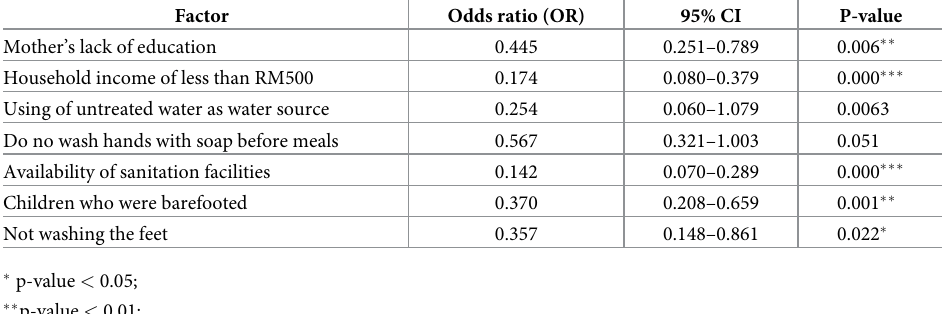
Table 7. Logistic regression analysis of risk factors associated with geohelminth infections among the children of 13 villages in Kota Marudu. Factor